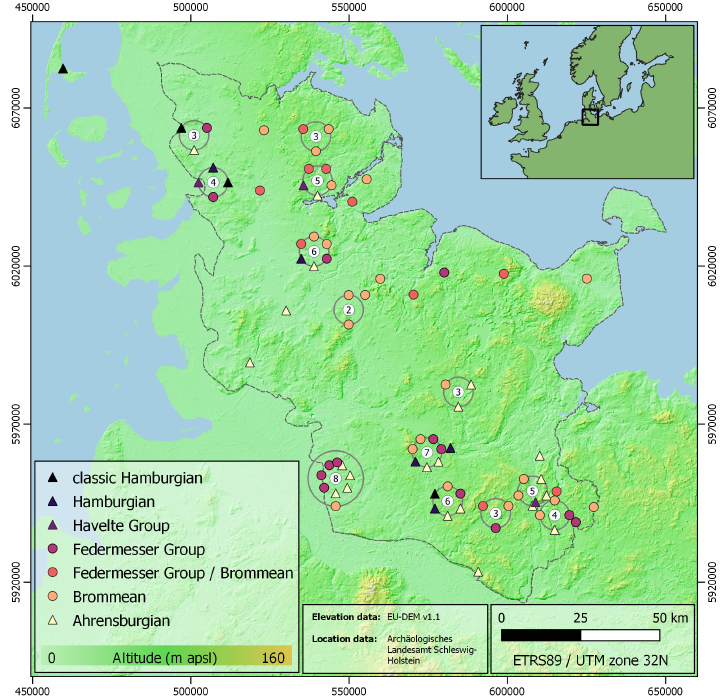
Figure 1. Archaeological find spots of reindeer hunters (triangles) and elk hunters (circles) in the study area in the north of Germany. The dotted line marks the area studied in this